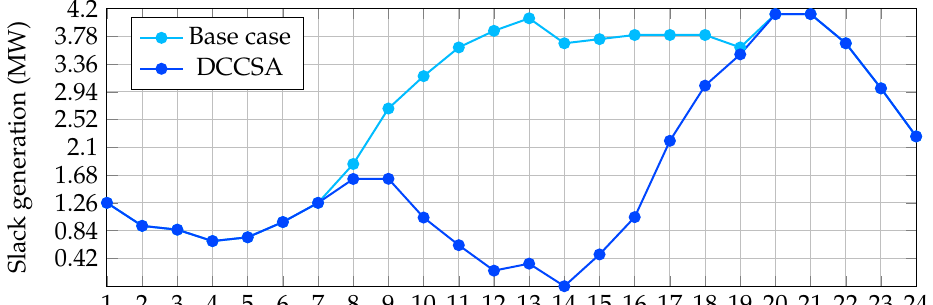
Figure 8. Impact of PV integration in the 69-node test